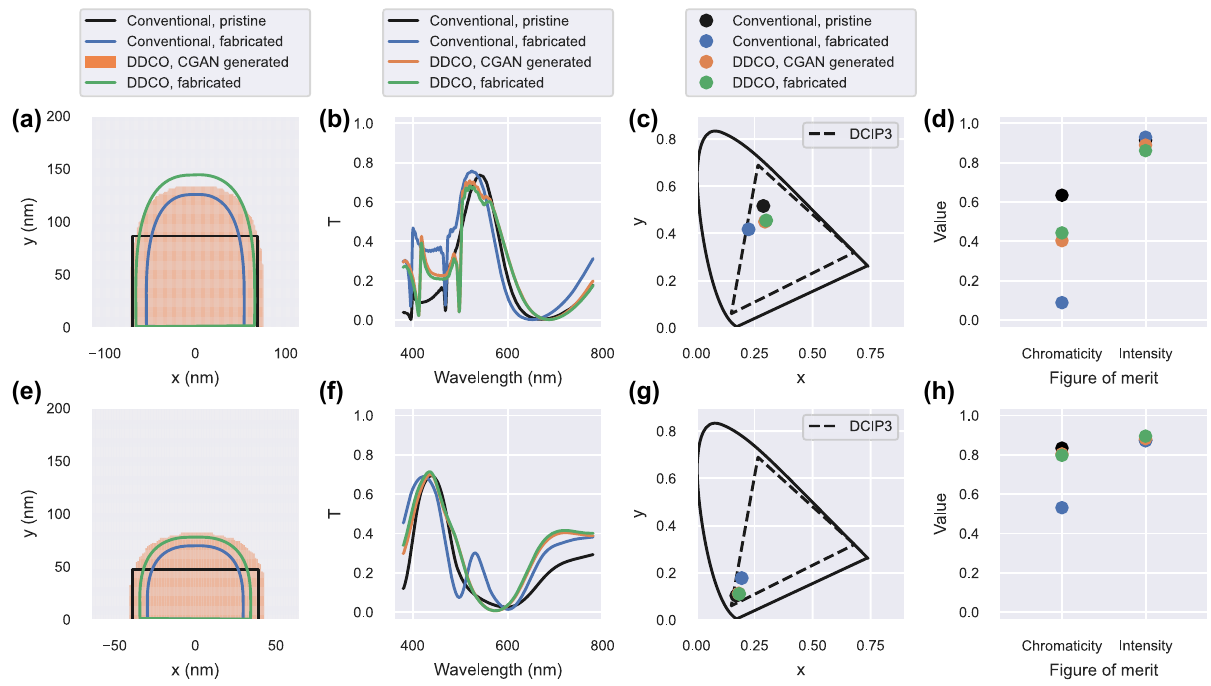
Figure 6: Waveguide-grating optimization